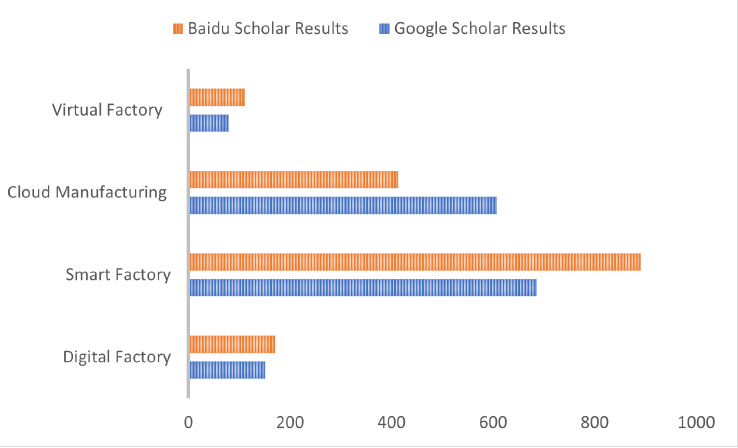
Figure 1. Matching results on search engines of keywords reported in Table